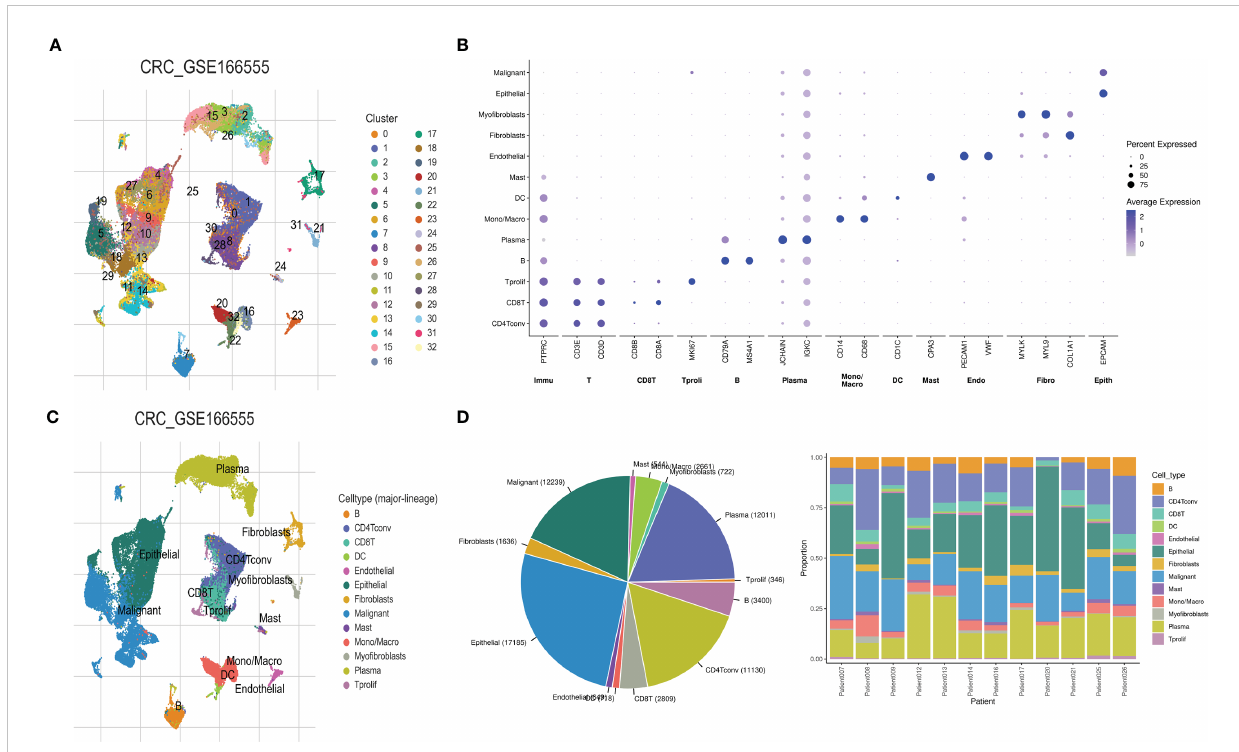
FIGURE 4 Cell heterogeneity in the microenvironment of colorectal cancer revealed by single-cell sequencing. (A) The UMAP map revealed 33 different cell clusters, (B) cell marker dot pattern, (C) 13 cell types were obtained after cell annotation, and (D) fan and stacked bar graphs show the proportion of the different cell